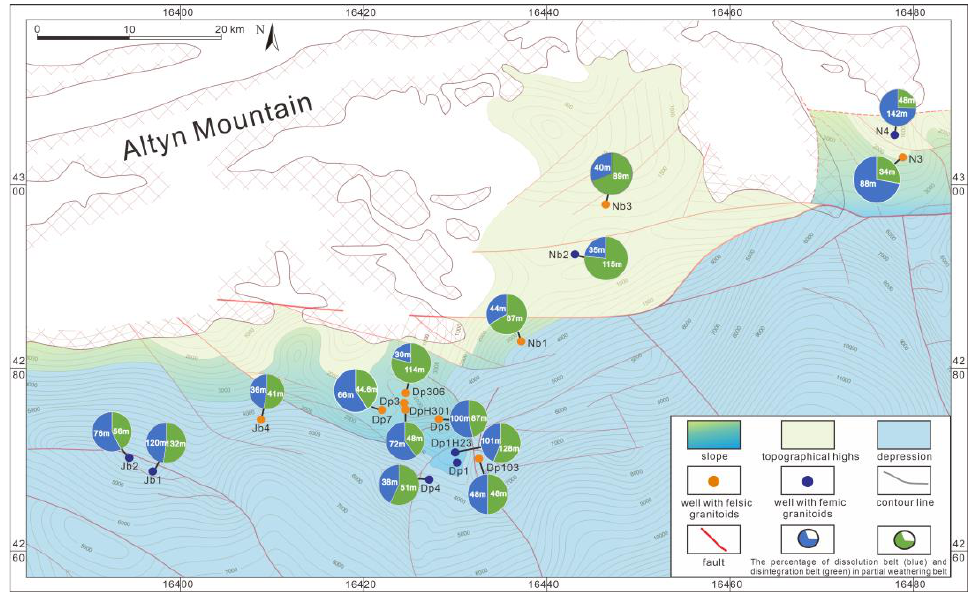
Figure 14. Thickness variation of partial weathering crust layer and its relationships among lithology, tectonism, and paleogeomorphology (the contour values of paleogeomorphology are interpreted based on the T6 reflection layer of seismic data; these values represent the height of the basement top before the deposition above).